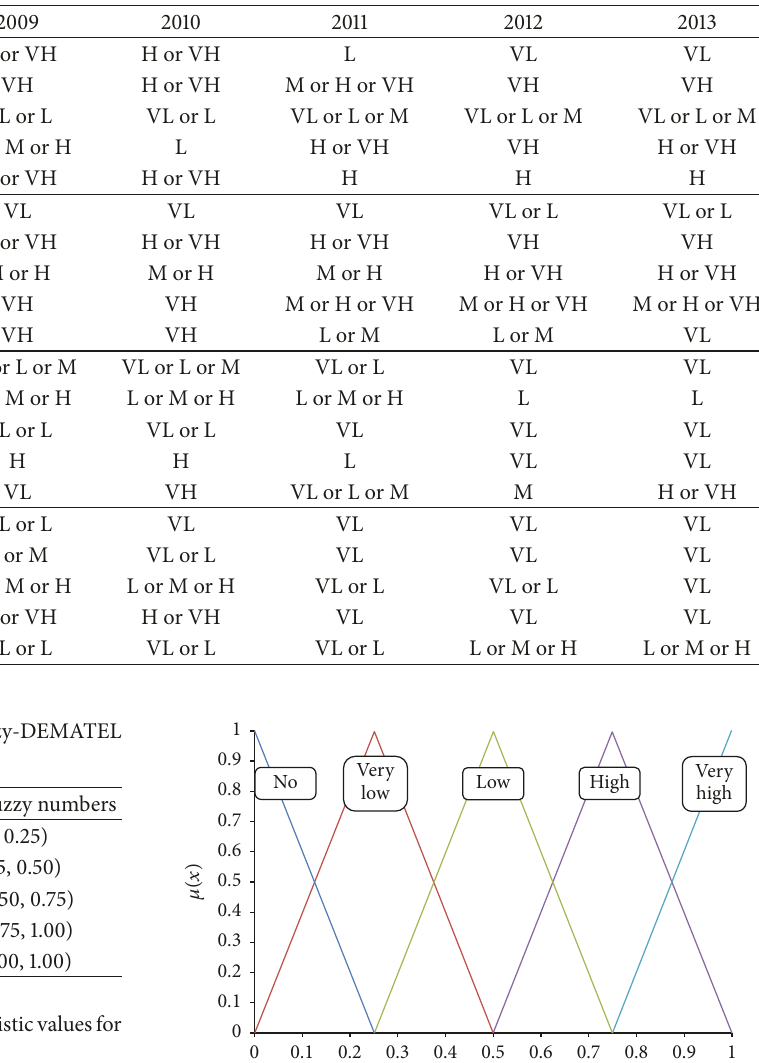
Table 3: Evaluation of each indicator by 12 linguistic values.